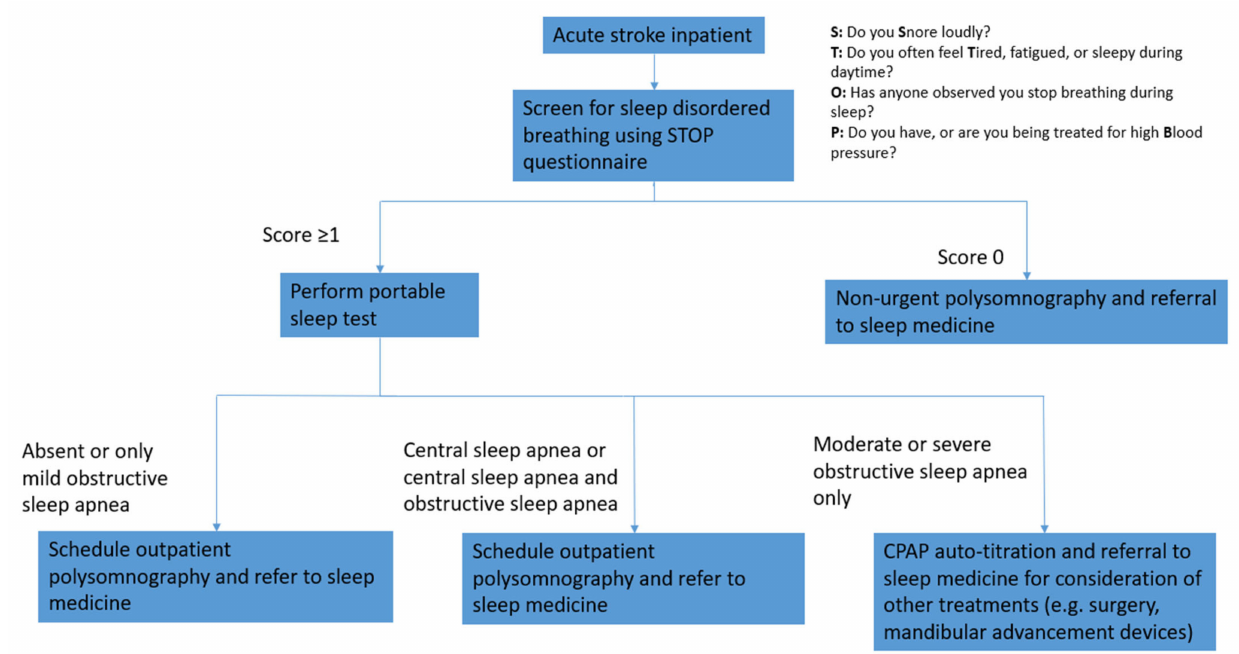
Figure 2. Sleep Disordered Breathing Screening Algorithm. Our proposed algorithm for screening patients for sleep disordered breathing after an acute